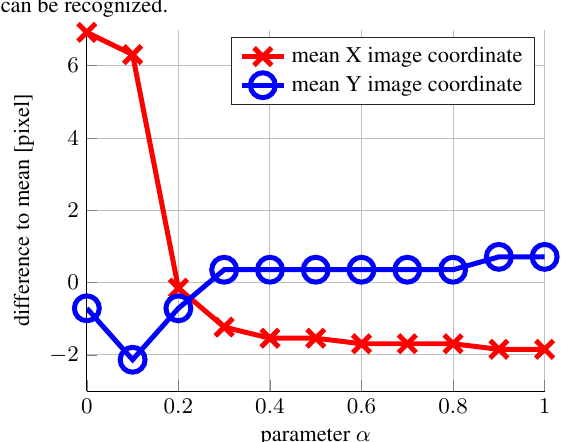
Figure 7: Dependence of geometry and topology scores (a) as well as the X and Y coordinates (b) of the final lattice nodes on parameter